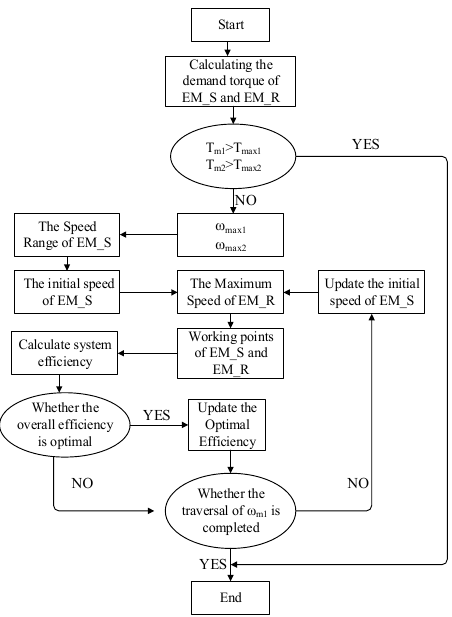
Figure 4. The flow chart of power distribution.